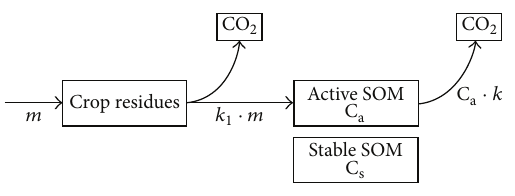
Figure 2: Diagram of AMG